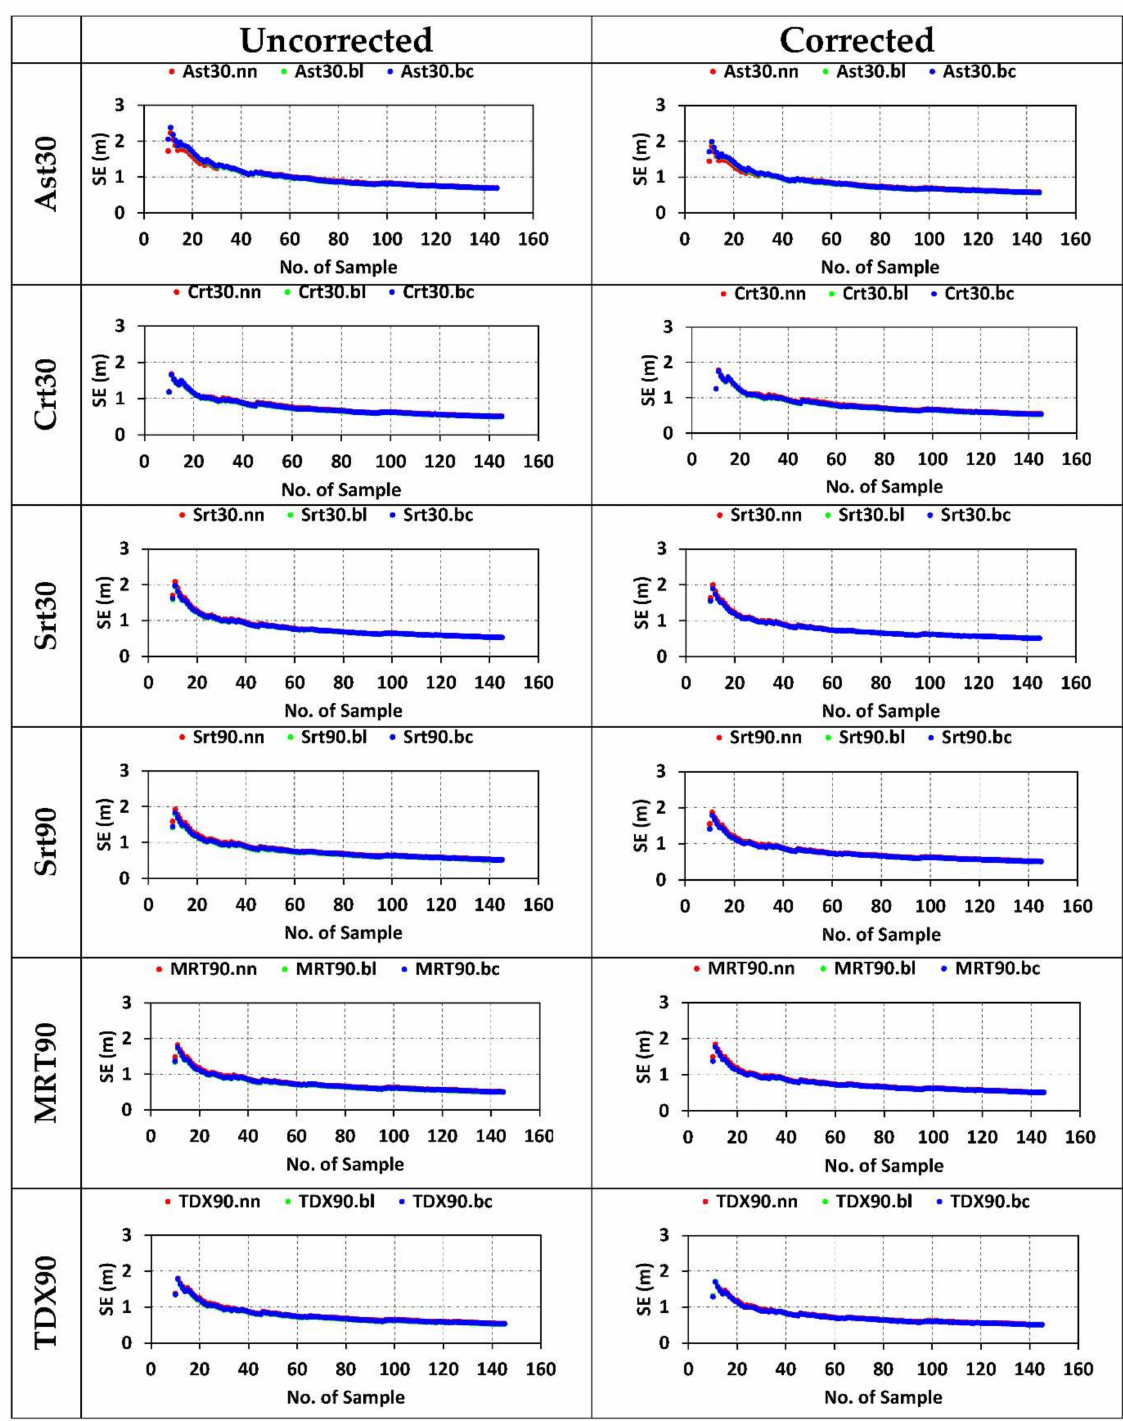
Figure 7. The variation in the calculated values of standard error (SE) with increasing number of GCPs (randomly selected) exhibit substantial drop in the SE up to approximately 40–60 GCPs (Ast30, Srt30, Srt90, Crt30) and, thereafter, remains nearly invariable (for 60–145 no. of GCPs). There is a minor change in SE for corrected space-borne elevation datasets. The nn, bl, and bc refer to the interpolation methods. (Ast30 = ASTER GDEM V3, Crt30 = CartoDEM v3.R1, Srt30 = SRTM.v3, Srt90 = SRTM.v4.1, MRT90 = MERIT DEM, TDX90 = TanDEM-X 90